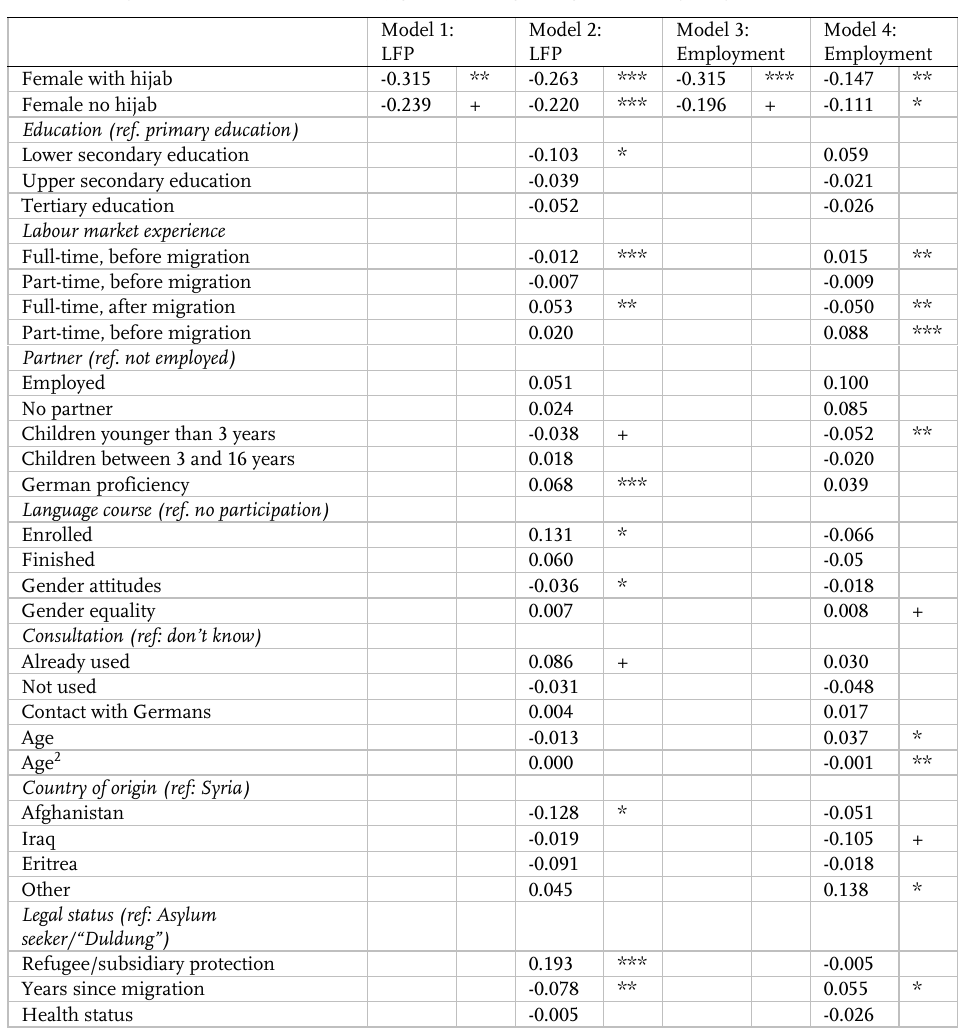
Table A.3 : Results from logistic regression (1: Labour market participation; 0: No labour market participation), pooled models and models by gender, average marginal effects